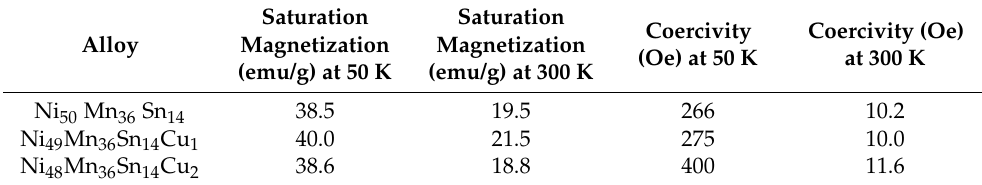
Table 3. Magnetic parameters derived from Figure 8 hysteresis loops.